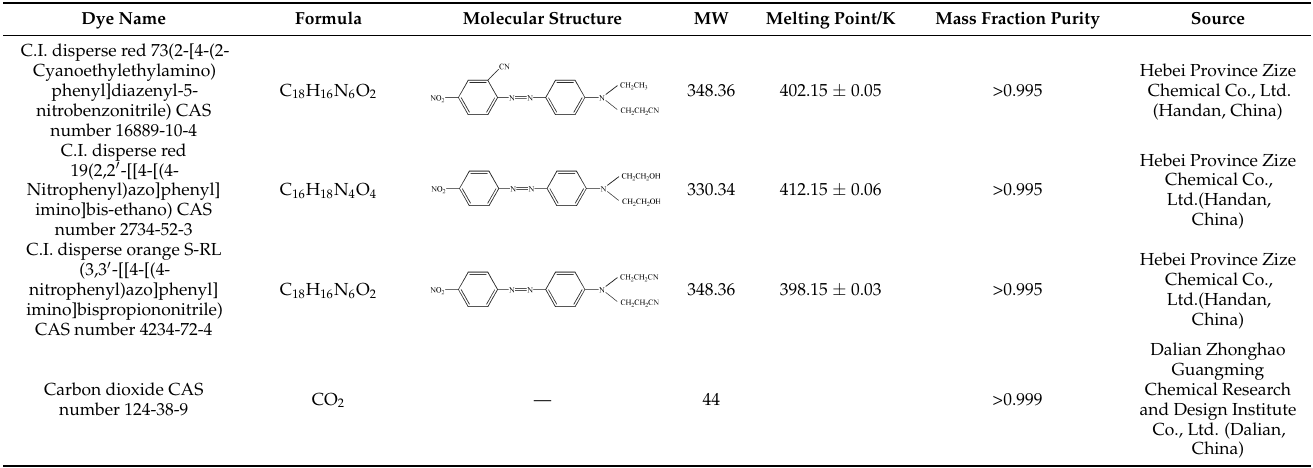
Table 1. CAS number, chemical formula, molecular structure, molecular weight, source and mass fraction purity of the three disperse dyestuffs.